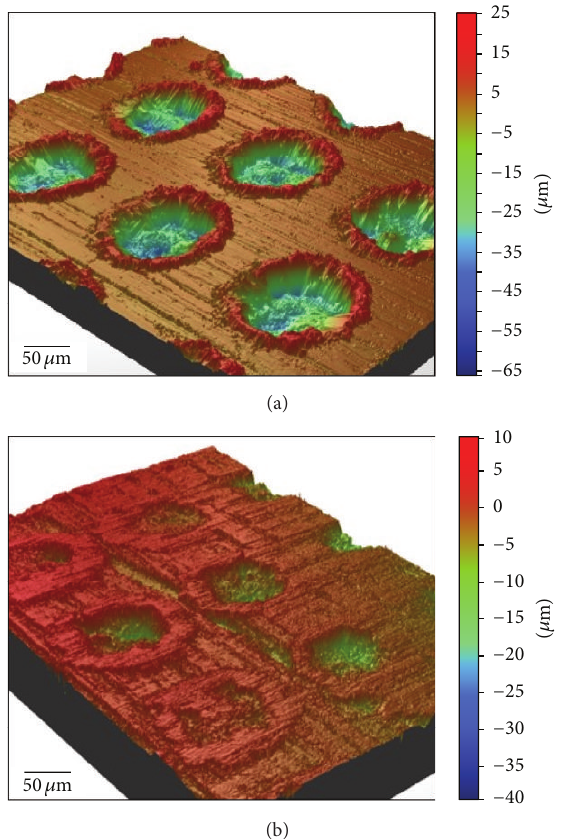
Figure 7: Surface topography—texture #1, die radius: (a) before and (b) after the stamping